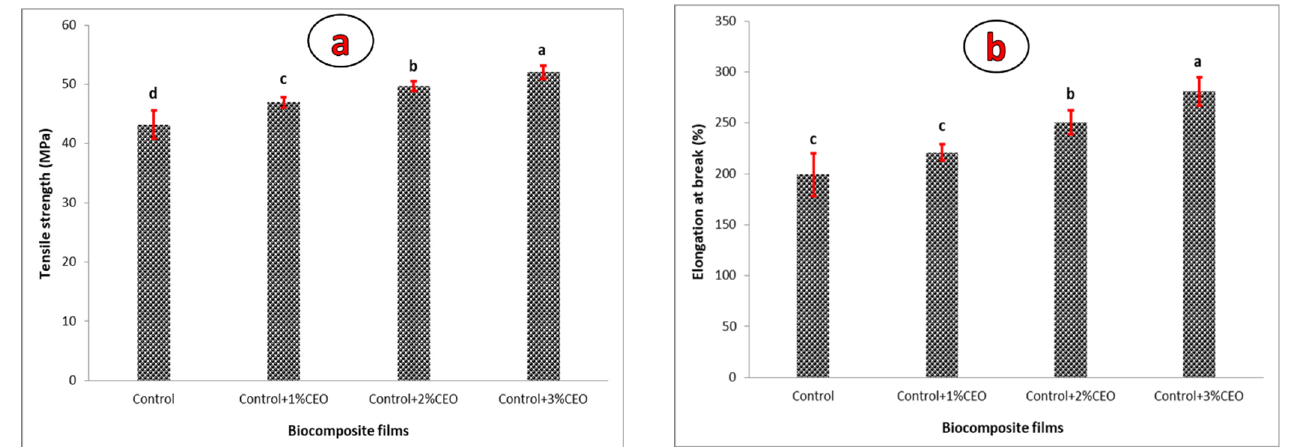
Figure 1. TS ( a ) and EAB ( b ) of PBS-PVA films containing 0–3% CEO.